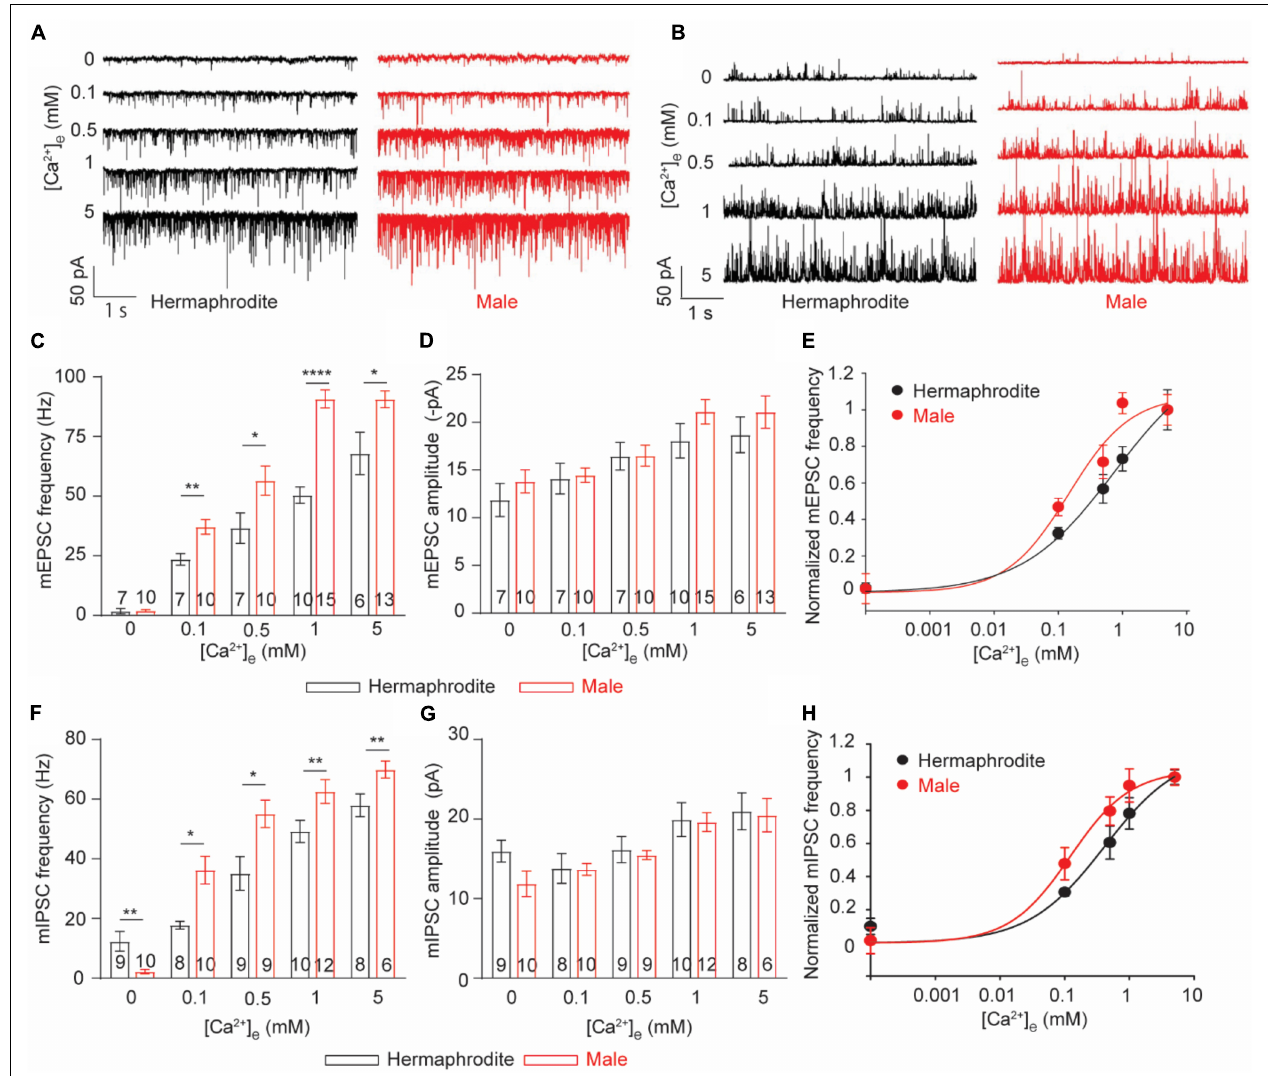
FIGURE 3 | C. elegans males exhibit enhanced Ca 2 + sensitivity of ACh and GABA release at the NMJs. (A,B) Sample traces of mEPSC recorded from the NMJs of adult hermaphrodites and males under distinct extracellular calcium ([Ca 2 + ] e ) (0, 0.1, 0.5, 1, and 5 mM). Bar graph of the frequency (C) and the amplitude (D) of mEPSC recorded from the NMJs of adult hermaphrodites and males under distinct [Ca 2 + ] e . The Ca 2 + sensitivity of spontaneous ACh release (E) and spontaneous GABA release (H) greatly enhanced in adult males. The normalized frequency of mEPSC and mIPSC is plotted as a function of [Ca 2 + ] e . The plots are fitted by the Hill equation with difference EC50 (mEPSC: 0.1450 males vs. 0.8569 hermaphrodites; mIPSC: 0.1034 males vs. 0.4819 hermaphrodites). Bar graph of the frequency (F) and the amplitude (G) of mIPSC recorded from the NMJs of adult hermaphrodites and males under distinct [Ca 2 + ] e . Sample sizes ( n numbers) are indicated in the bars of each graph. All data are represented as mean ± SEM (* p < 0.05, ** p < 0.01, **** p < 0.0001, two-way ANOVA followed by Bonferroni’s post hoc